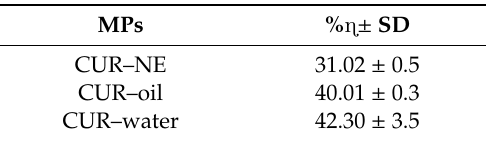
Table 1. % ï of Table 1. % ɳ of CUR–MPs.